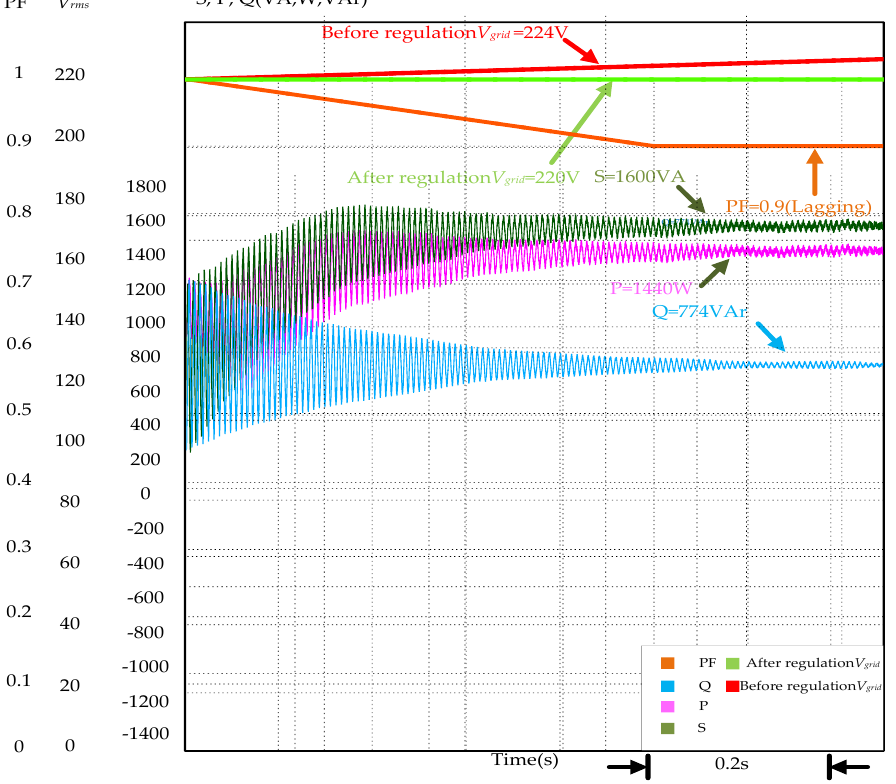
Figure 13. The mains voltage V grid before and after regulation, output PF regulation, real power, reactive power, and apparent power of the smart inverter when the per-unit value of mains voltage was between 1p.u. and 1.03p.u.